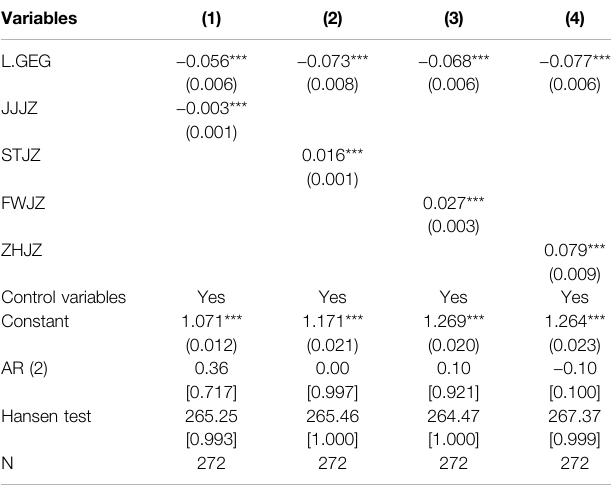
TABLE 10 | Robustness tests for replacing the explanatory variables.